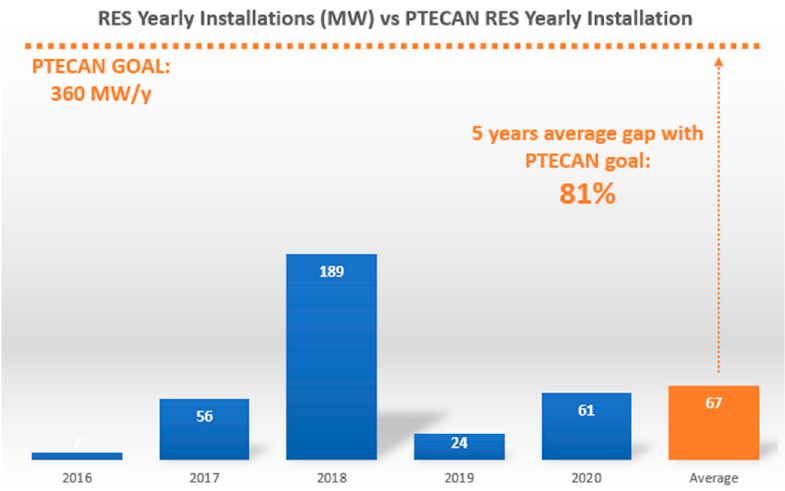
Figure 8. RES yearly installation vs. PTECAN RES yearly objective. Source: Own elaboration sourced with the Canary Islands Yearbook and PTECAN.